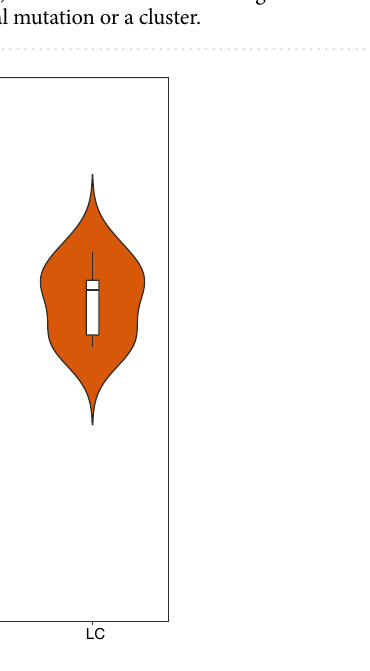
Figure 4. Frequency of the genotype D-specific mutational pattern. The violin plot compares the frequency of the mutational pattern (A12S/P33S/P46S/T36G-D) between the clinical groups. The internal white bar represents the interquartile range with the median in a black horizontal line, whereas the vertical line shows the 95% confidential interval. The violin shape indicates the probability density, in which wider sections indicate a higher probability that a patient will have a given frequency of the mutational pattern. The p value was determined by performing the Kruskal–Wallis test plus and the posthoc Dunn test, and is reported as asterisks (1 asterisk, <